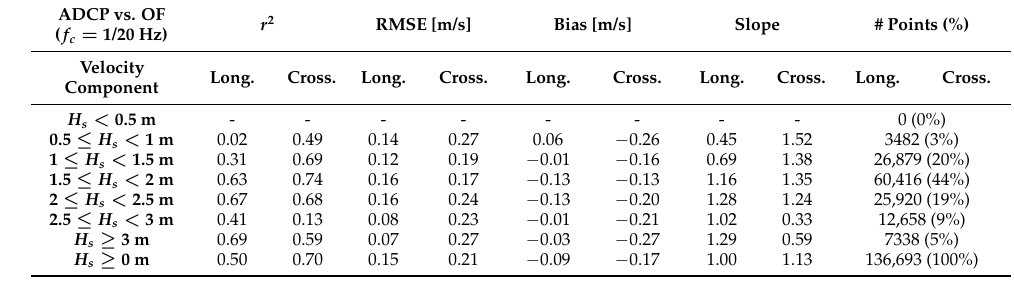
Table 3. Five minute time-averaged ADCP vs. optical flow surface velocity components from 8 to 15 October 2018 under different ranges of offshore significant wave height H s during low tide when the ADCP is located inside the surf zone. Optical flow velocities are computed from low-pass filtered images with f c = 1/60 Hz. ADCP vs. OF ( f c = 1/60